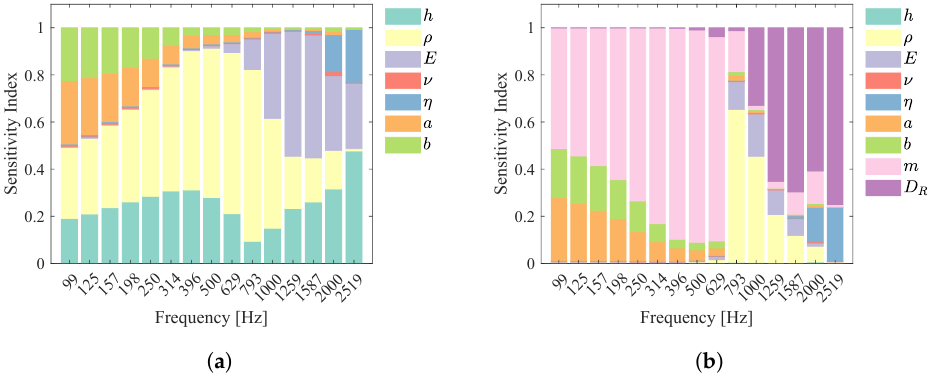
Figure 6. MDI-based sensitivity of the STL of finite plates evaluated with the correction factor: ( a ) the inputs of the surrogate only consist of the STL variables ( RMSE = 0.36 ± 0.01 dB); ( b ) physics-guided features m and D R are included as input for the surrogate ( RMSE = 0.25 ± 0.01 dB).